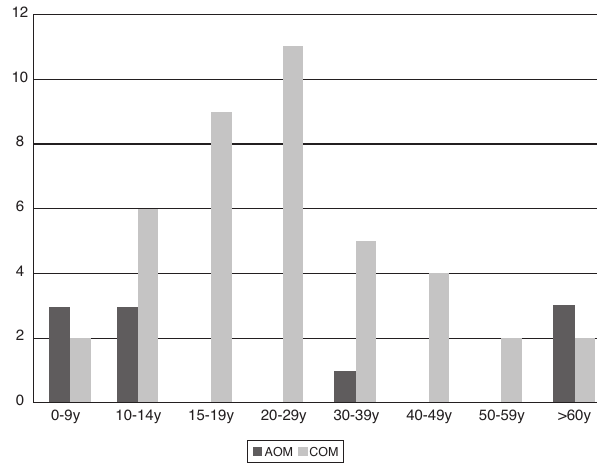
Figure 4 Distribution of intracranial complications cases by age intervals and type of otitis. AOM ICC cases (black bars) are seen in the first 2 decades and then after age 40, reflecting the incidence of AOM in the population overall. COM ICC cases (gray bars) are more common in the second 15 years of life, reflecting the time that it takes for unrecognized or undertreated COM to develop into an